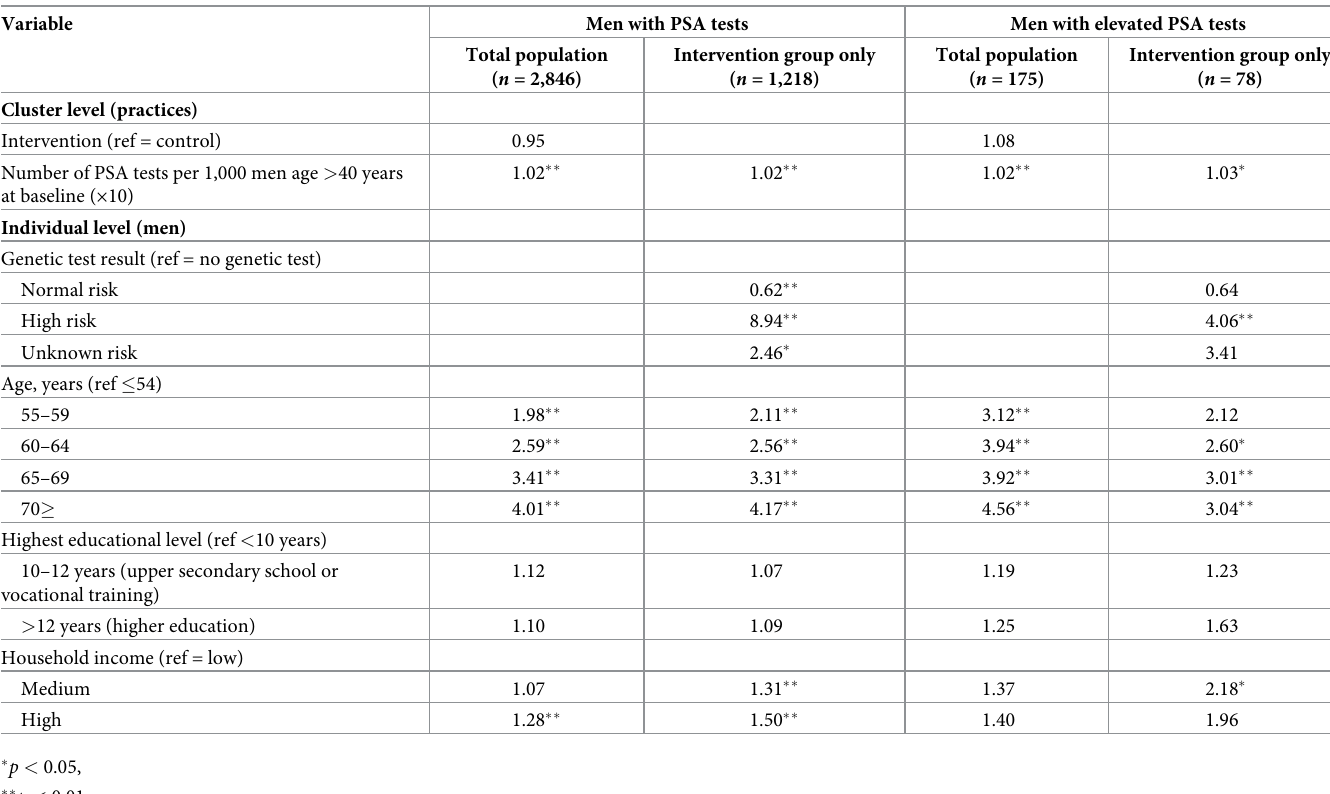
Table 3. Primary and secondary outcomes after 2 years’ follow-up: Adjusted multilevel logistic regression model